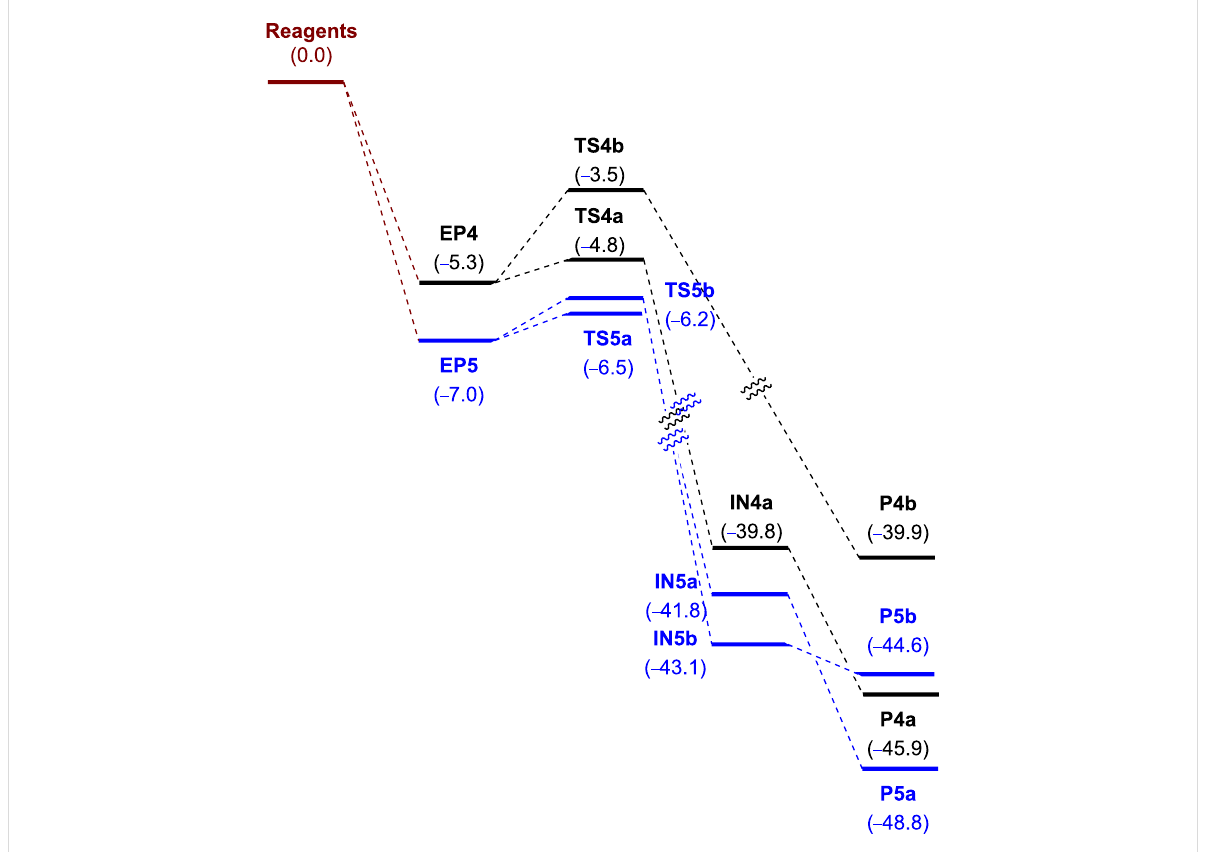
Figure 5: Energy profile for the oxidation of R4 and R5 . Relative energies, calculated at the B3LYP-d3bj/Def2TZVP/cpcm=water level of theory, are given in kcal/mol.